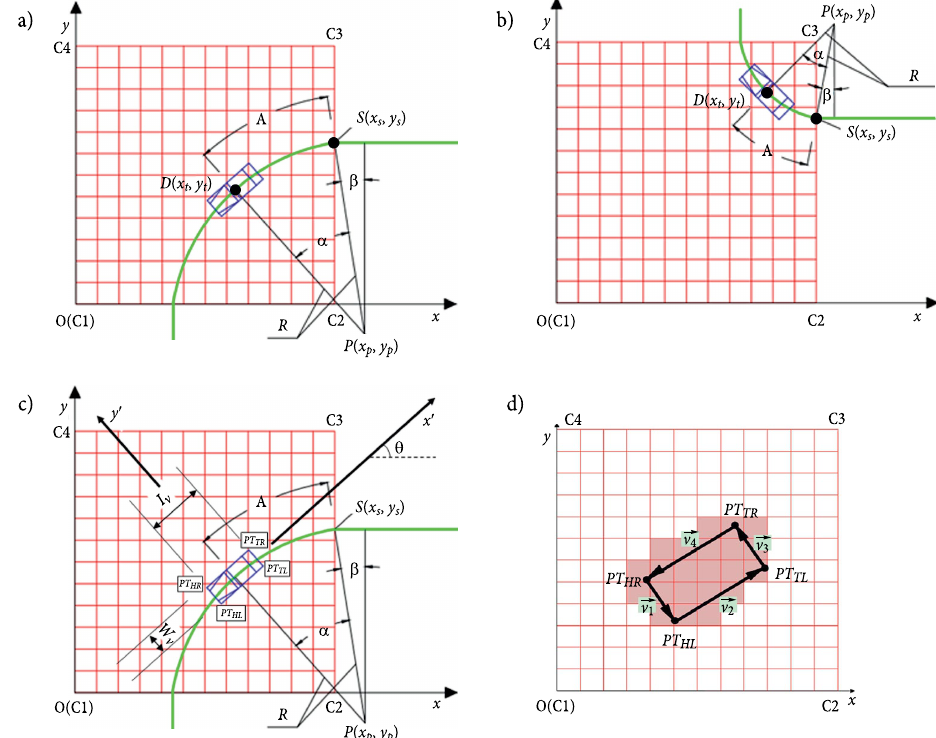
Fig. 2. Algorithms of determining the vehicle boundary and tiles